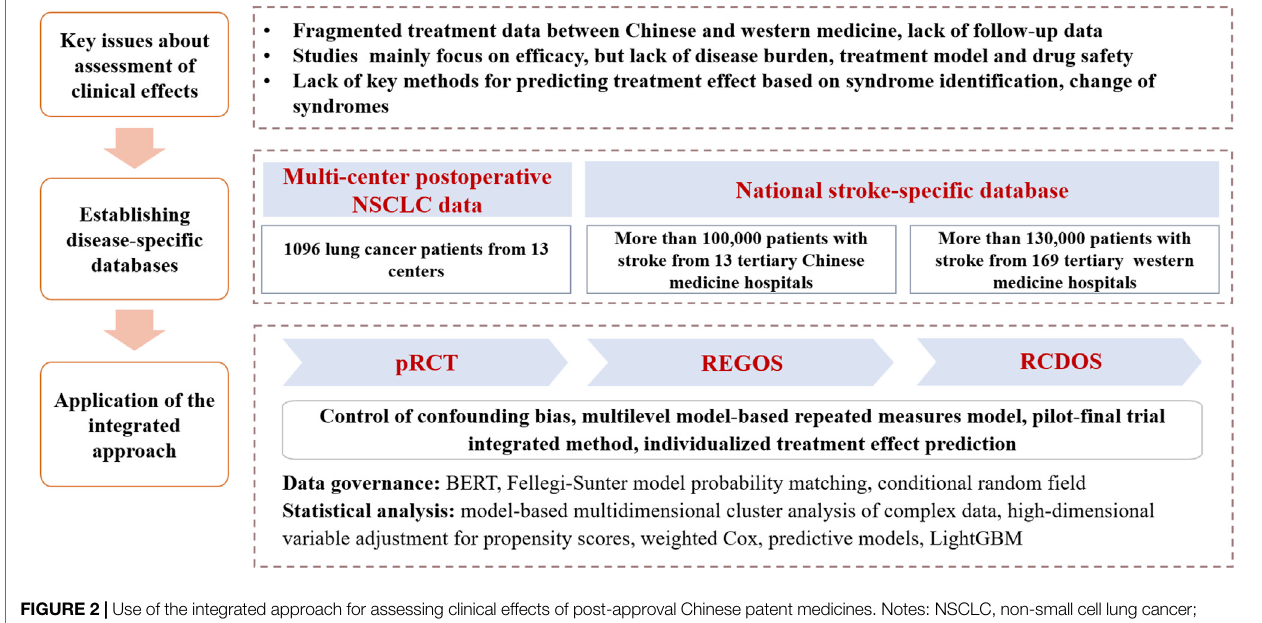
Frontiers in Pharmacology |